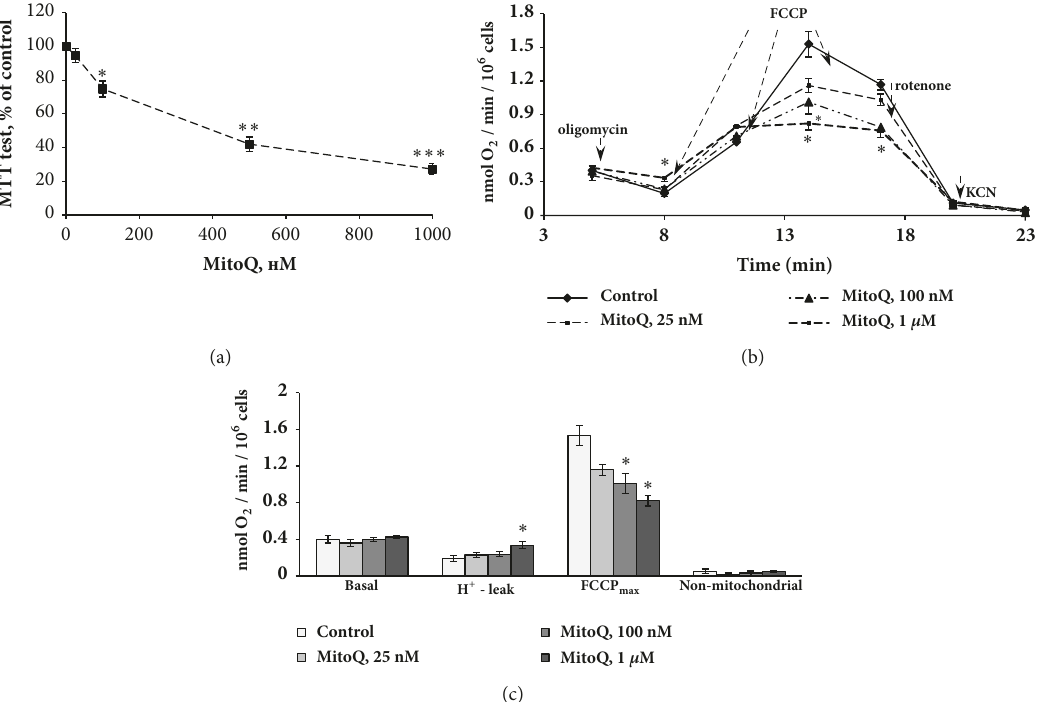
Figure 5: Evaluationof MitoQtoxicityon FUBEC.( a ) MTT-test,21 h incubationwith MitoQ.( b,c ) Oxygen consumption rate(3 h incubation withMitoQ).(b)Respirometryexperiments;(c)quantificationofdata.n=4independentexperiments;p < 0.05; ∗∗ p < 0.01; ∗∗∗ p < 0.001versus